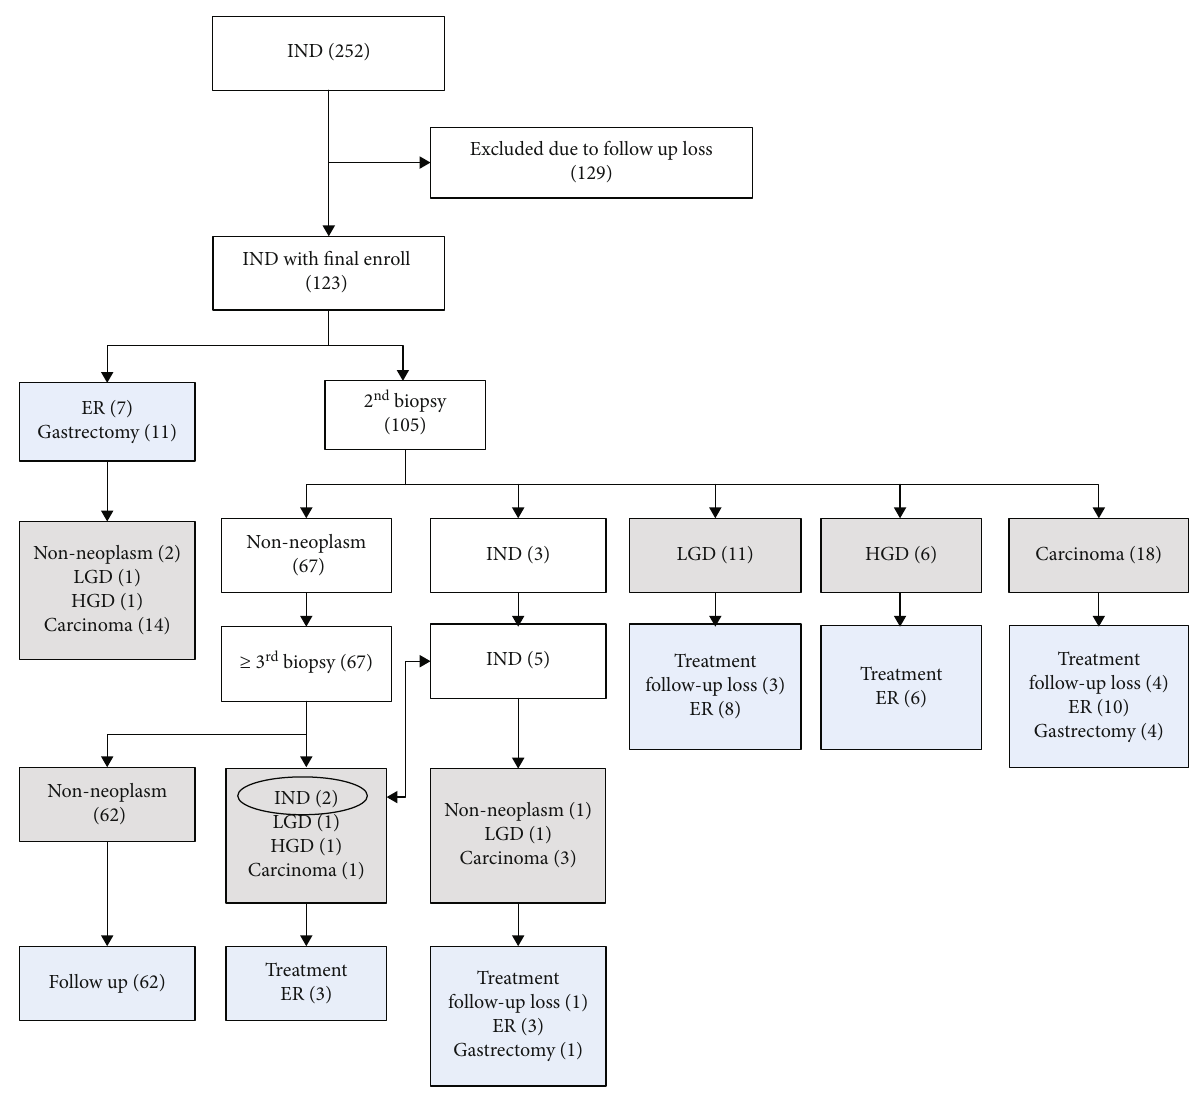
Figure 2: Flow chart of study inclusion and exclusion criteria and enrolment of 123 lesions with inde fi nite for dysplasia. ER: endoscopic resection; HGD: high-grade dysplasia; IND: inde fi nite for dysplasia; LGD: low-grade dysplasia. Table 1: The diagnostic delays and clinicopathological